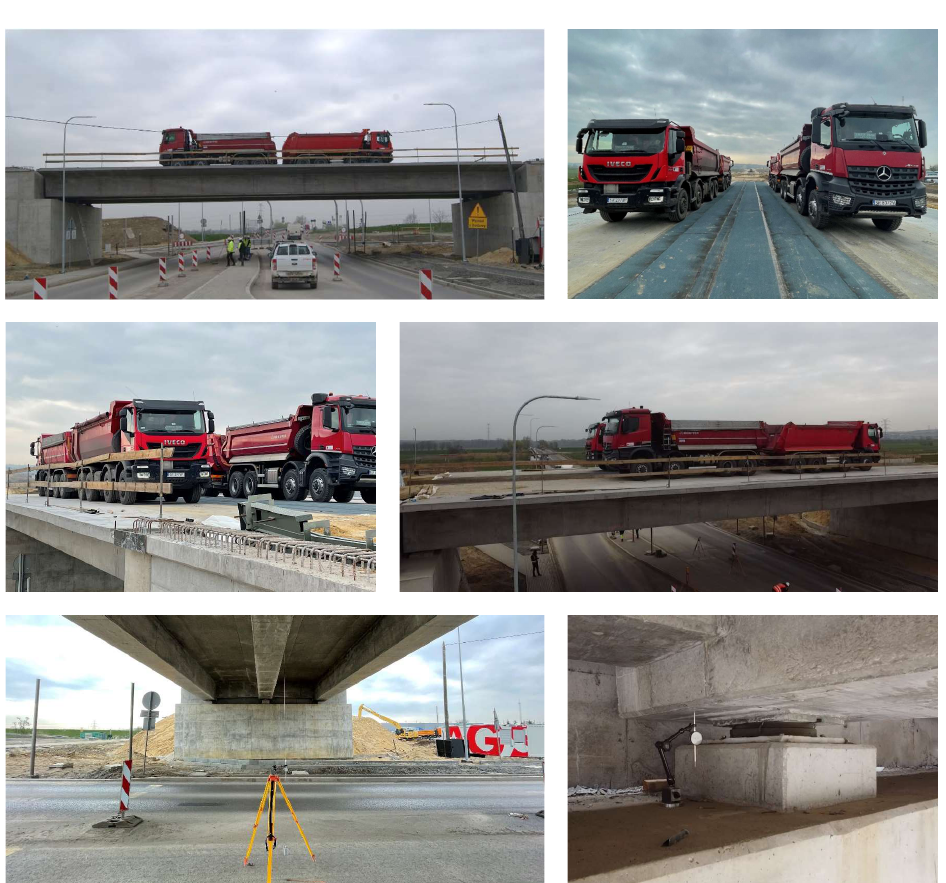
Figure 10. Superstructure of WG-4 bridge subjected to test load.